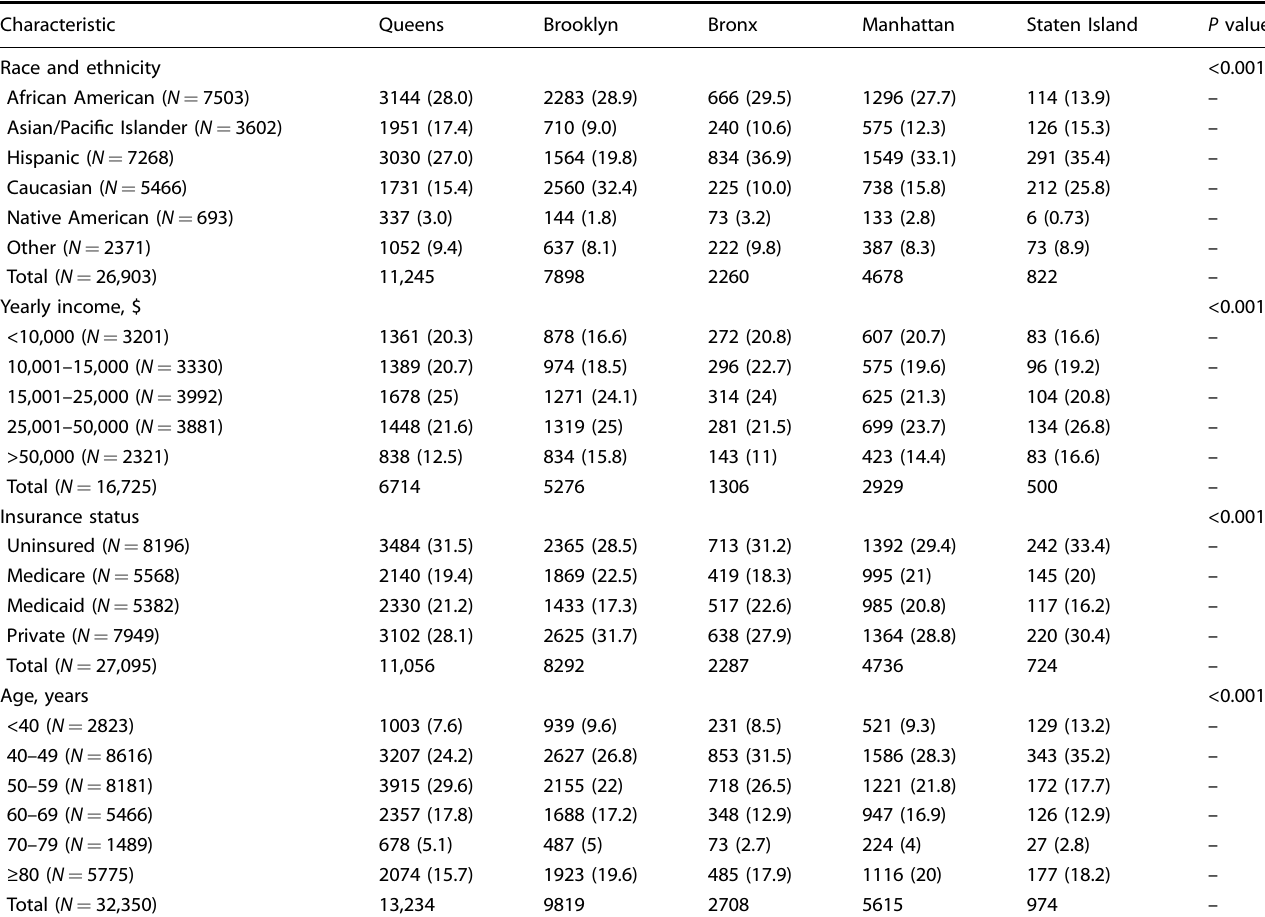
Table 1. Self-reported demographic information by borough of screening location ( N =